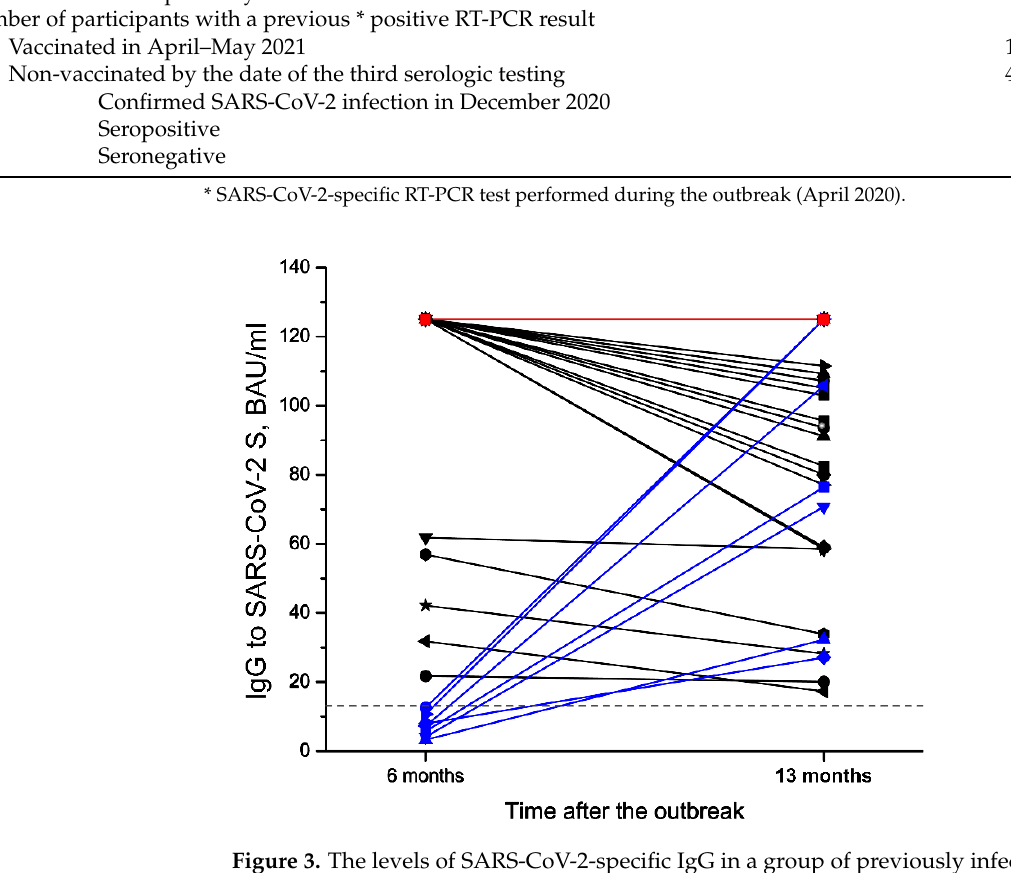
Table 4. Summarized results of the third serologic testing 13 months after the outbreak (12 May 2021). Total Number of Participants of the Third Serologic Testing The number of participants with a previous * negative RT-PCR result No confirmed SARS-CoV-2 infection and vaccination record